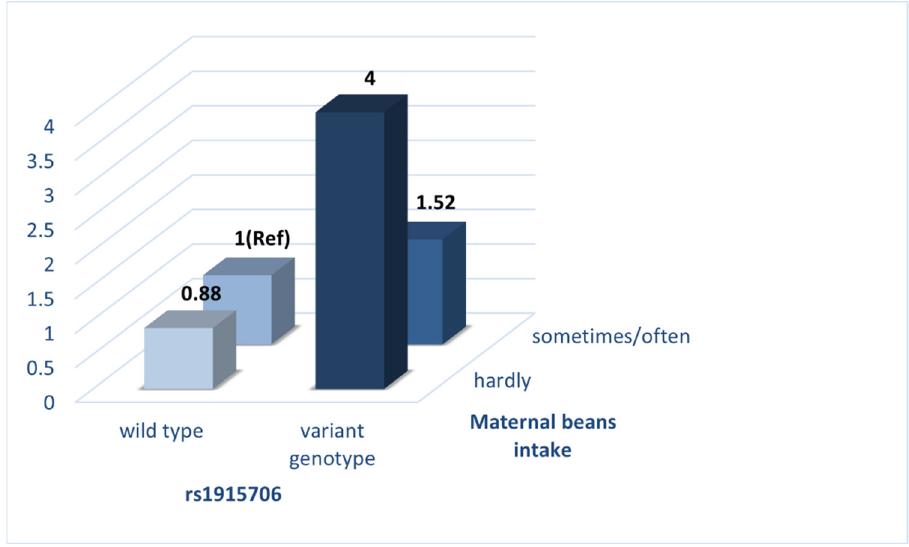
Figure 3. Interaction of rs1915706 and maternal beans intake on the risk of VSD in offspring.